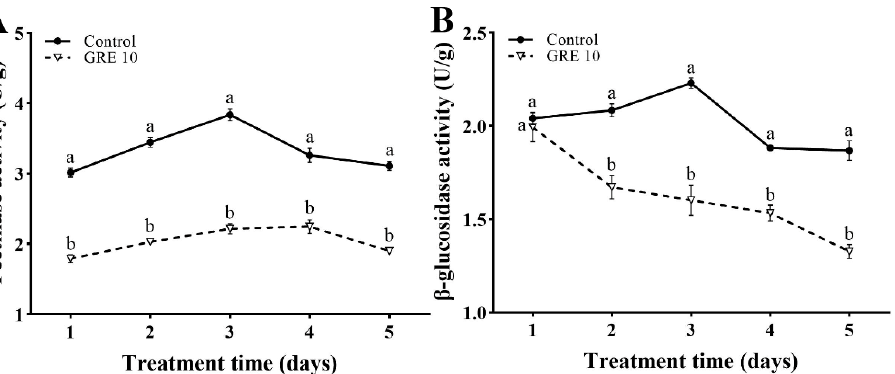
Figure 4. Effects of 10 mg/mL GRE on pectinase activity ( A ) and β -glucosidase activity ( B ) in F. solani . The bars on the curves represent standard deviations, and different letters at the same time point represent significant differences ( p < 0.05).